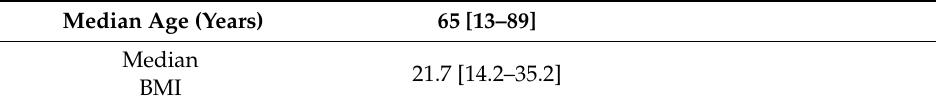
Table 1. Patient